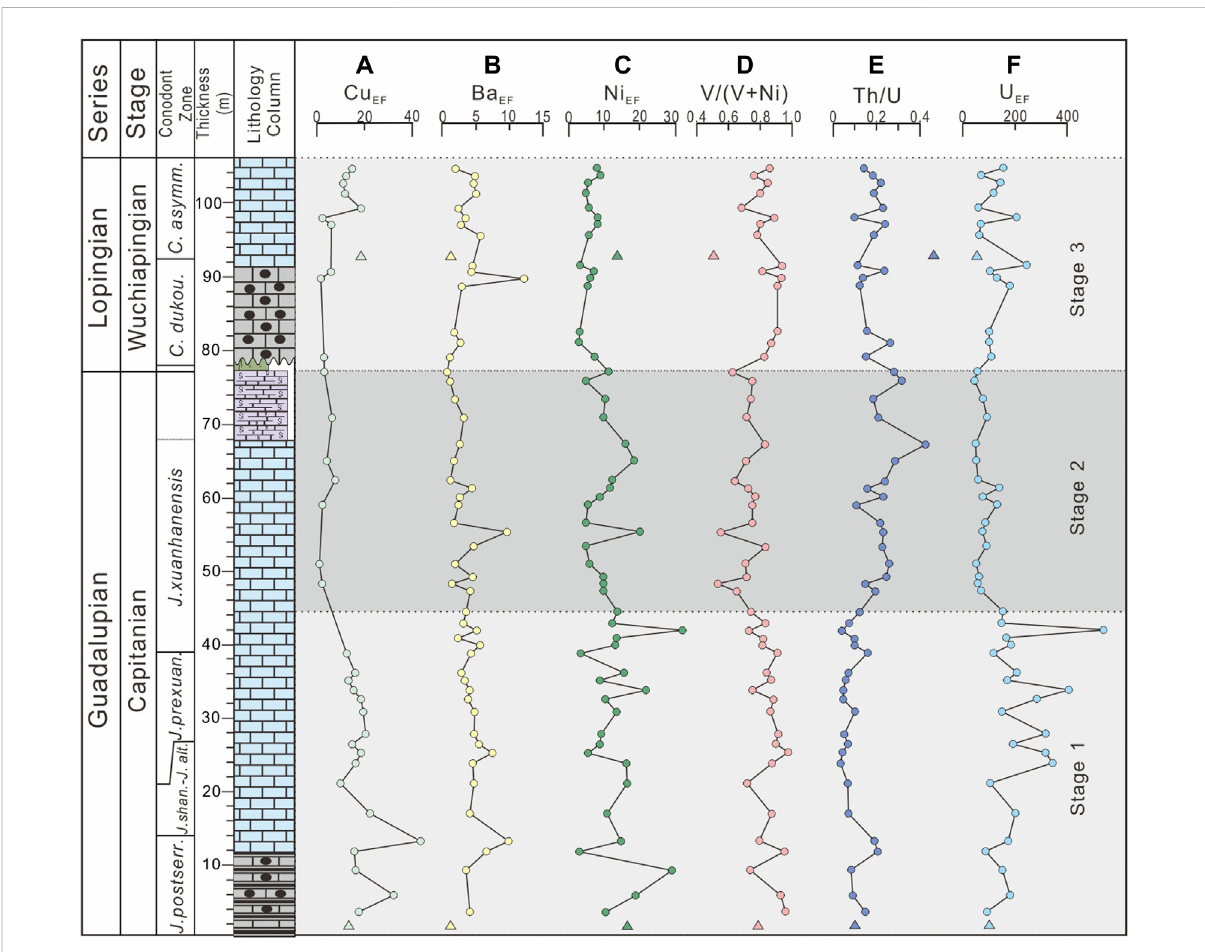
FIGURE 5 Pro fi les of (A) Cu EF , (B) Ba EF , (C) Ni EF , (D) V/(V+Ni), (E) Th/U and (F) U EF of Dukou section, the triangles are samples that may be affected by